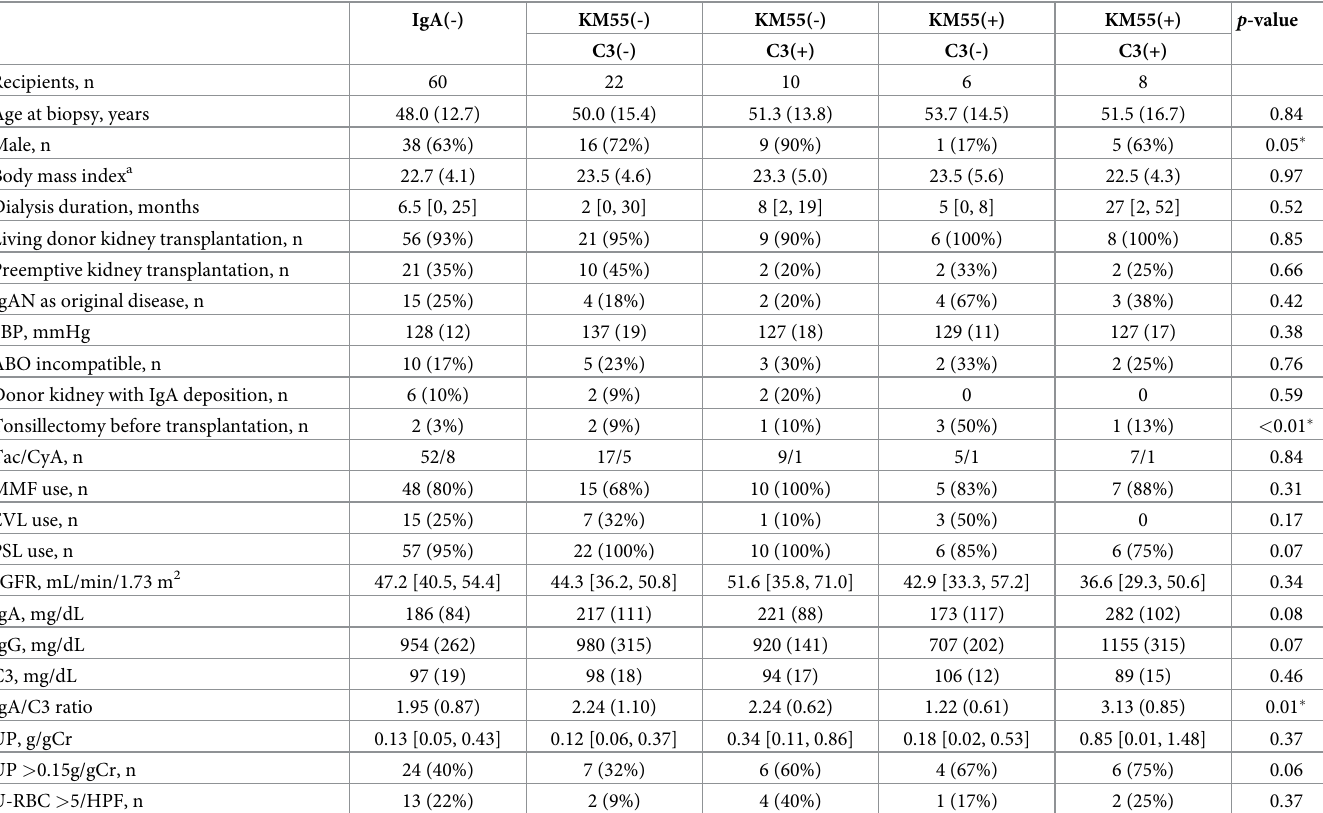
Table 2. Background characteristics of recipients in the